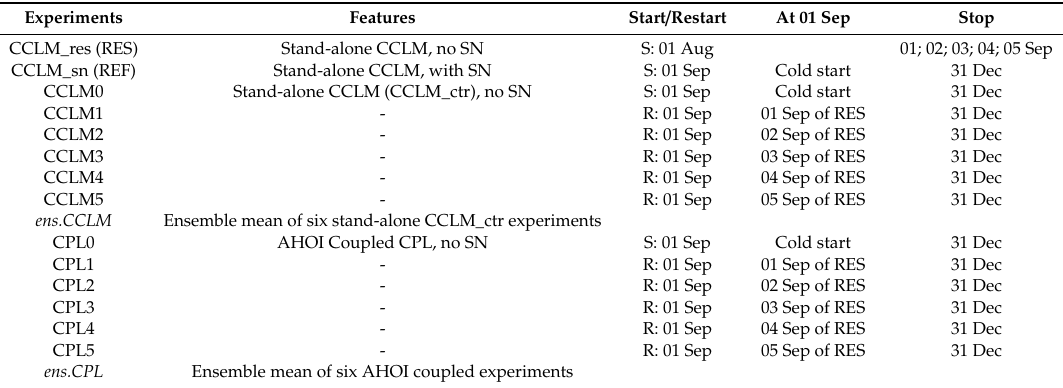
Table 1. Experimental